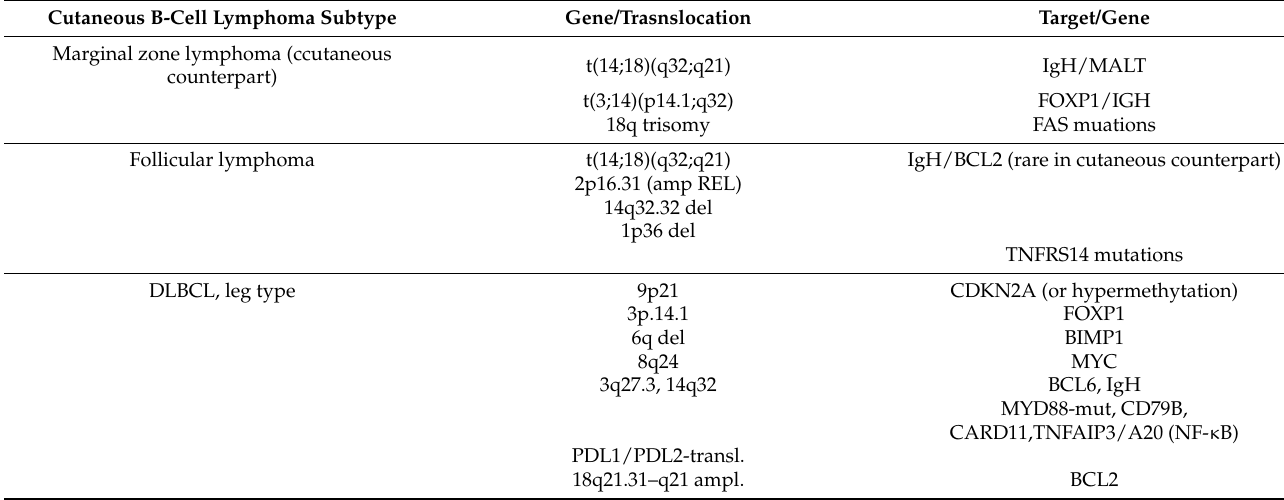
Table 6. Summary of genetic abnormalities reported in primary cutaneous B-cell